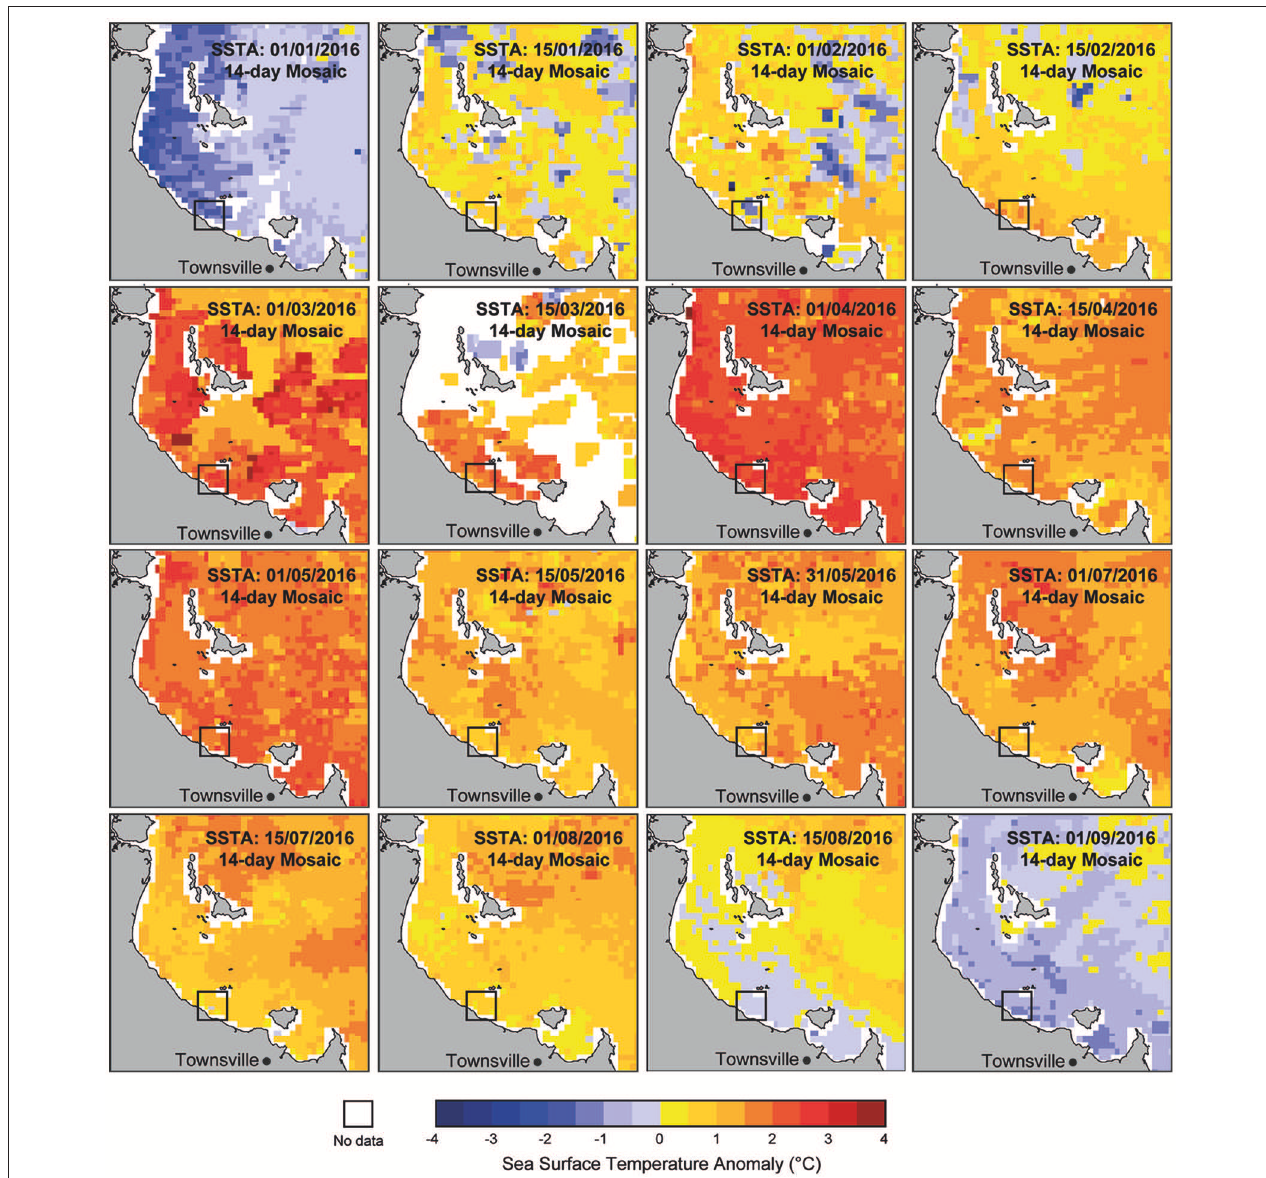
FIGURE 2 | Satellite-derived sea surface temperature anomalies (SSTA) for Halifax Bay (2 × 2 km grid size) showing the increase in SSTs since the start of 2016 in the region. SSTA are the difference between SST values and the long-term monthly mean SST. Maps were generated using 14-day mosaics for Halifax Bay from 1-day night-only SST (Garde et al., 2014). Note that temperatures in the vicinity of the proposed study area (black box) have been 2–3 ◦ above “normal” since February 2016. Data source: ReefTemp Next Generation (www.bom.gov.au/environment/activities/reeftemp/reeftemp.shtml).